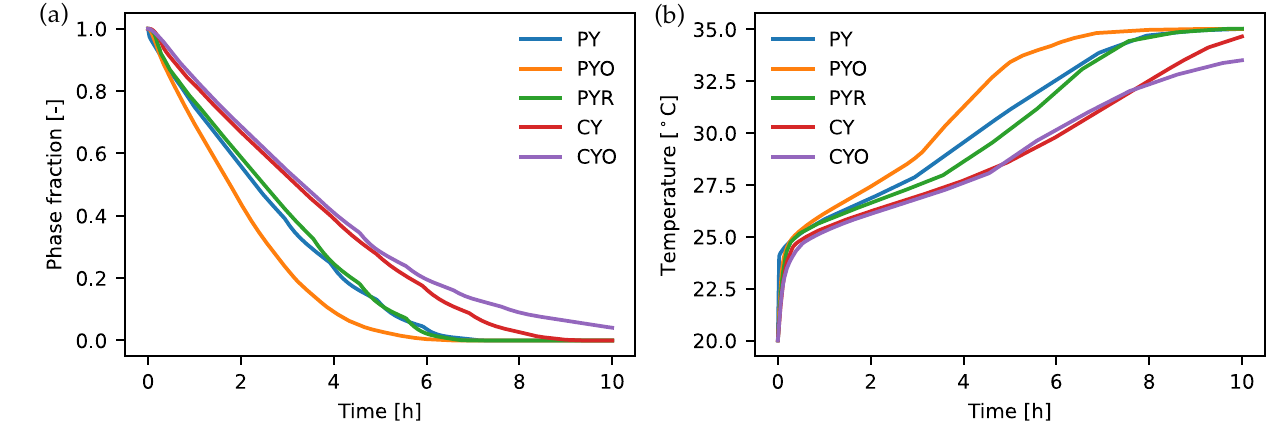
Figure 10. PCM panel volume-averaged ( a ) phase fraction and ( b ) temperature versus time during discharging. The phase-change process is considered complete when the phase fraction